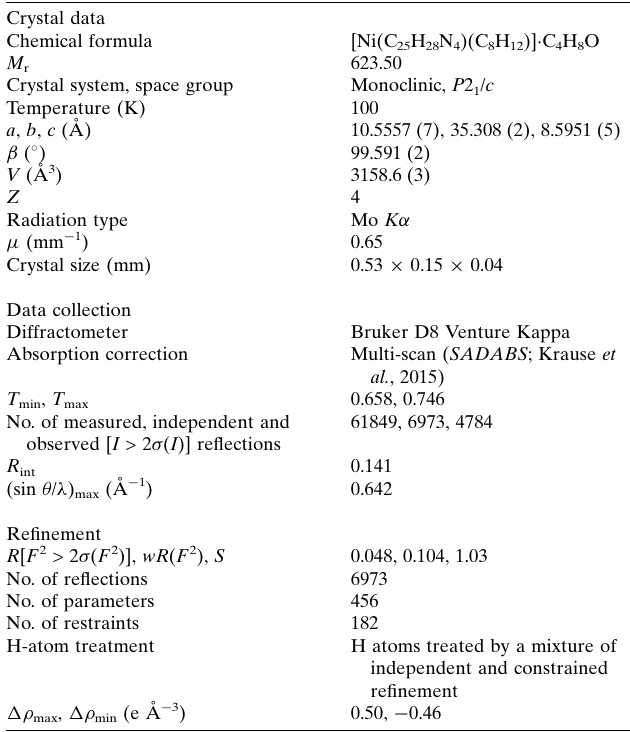
Table 2 Experimental details. Crystal data Chemical